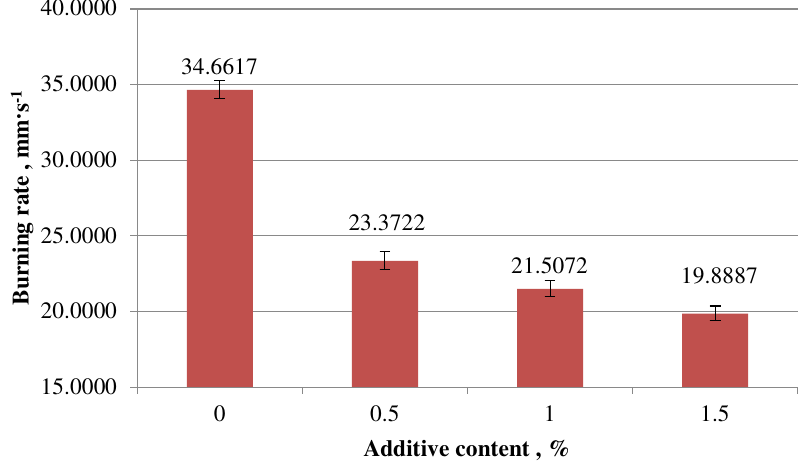
Figure 6. Effect of 6 on the burning rate of mixed potassium nitrate/zirconium.